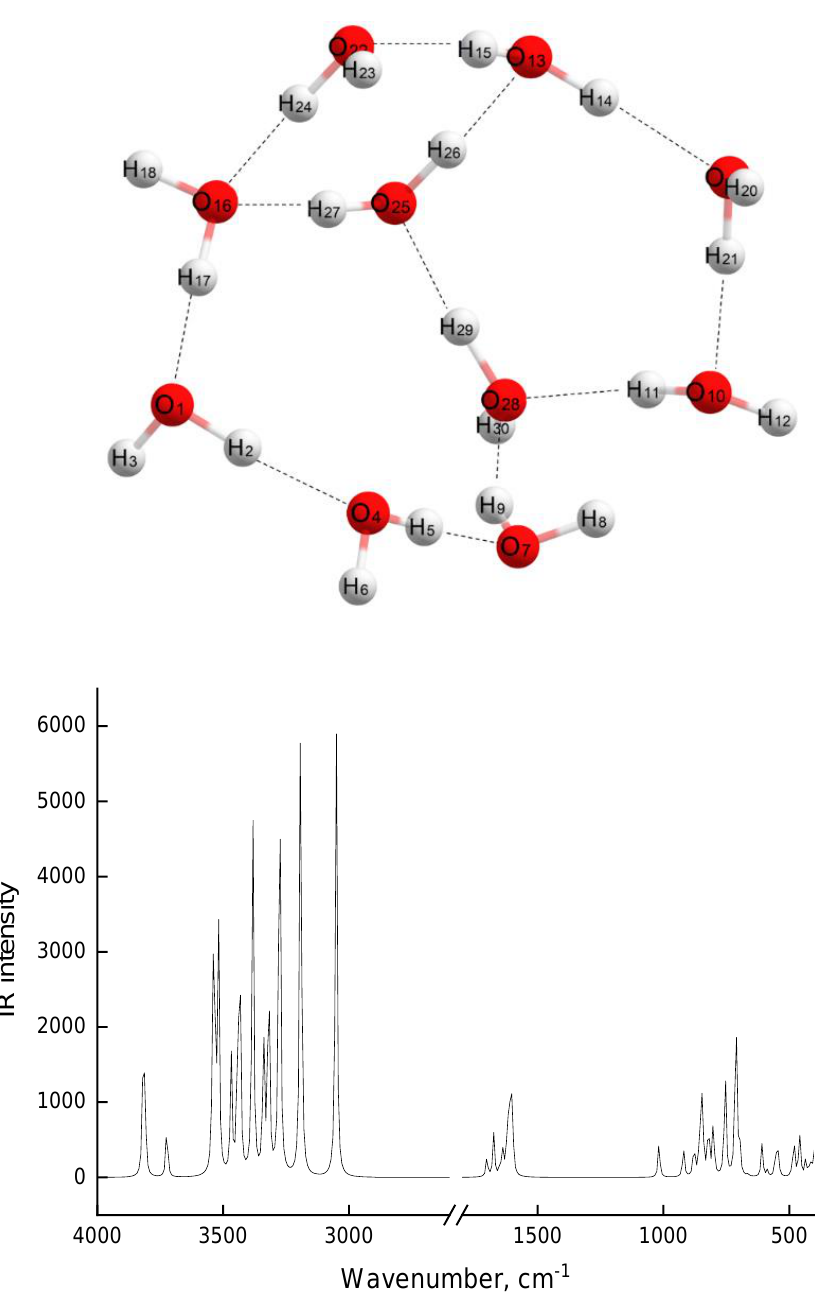
Figure 6. Model of 10H 2 O associate complex and theoretical IR spectrum of 10H 2 O model.